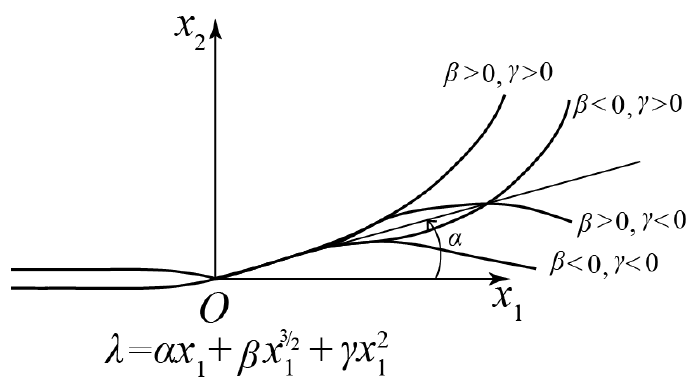
Figure 4: Comparison of the crack path stability